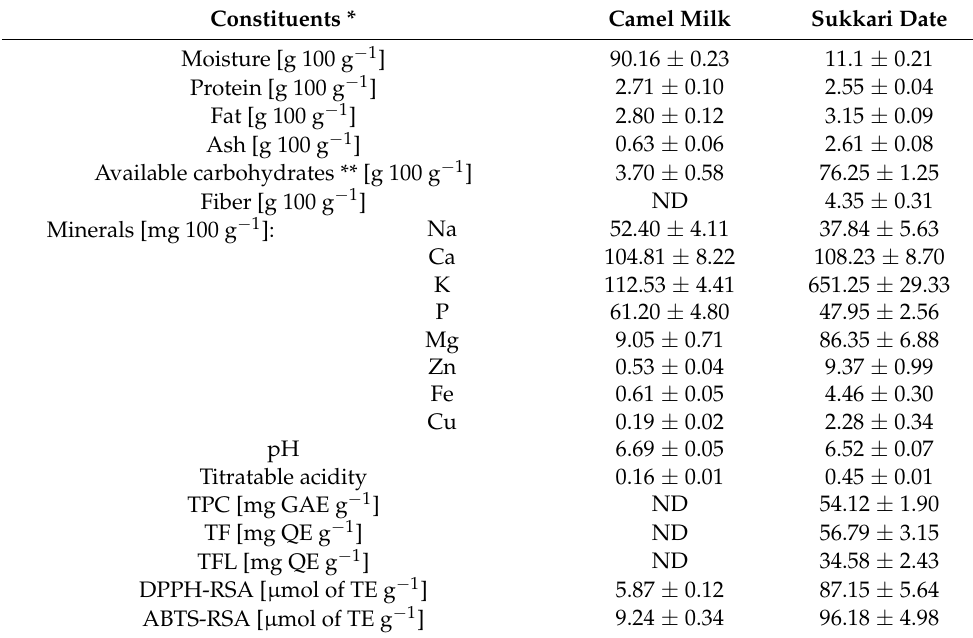
Table 1. Chemical composition and physicochemical properties of camel milk and SKD (mean ± SE), n =